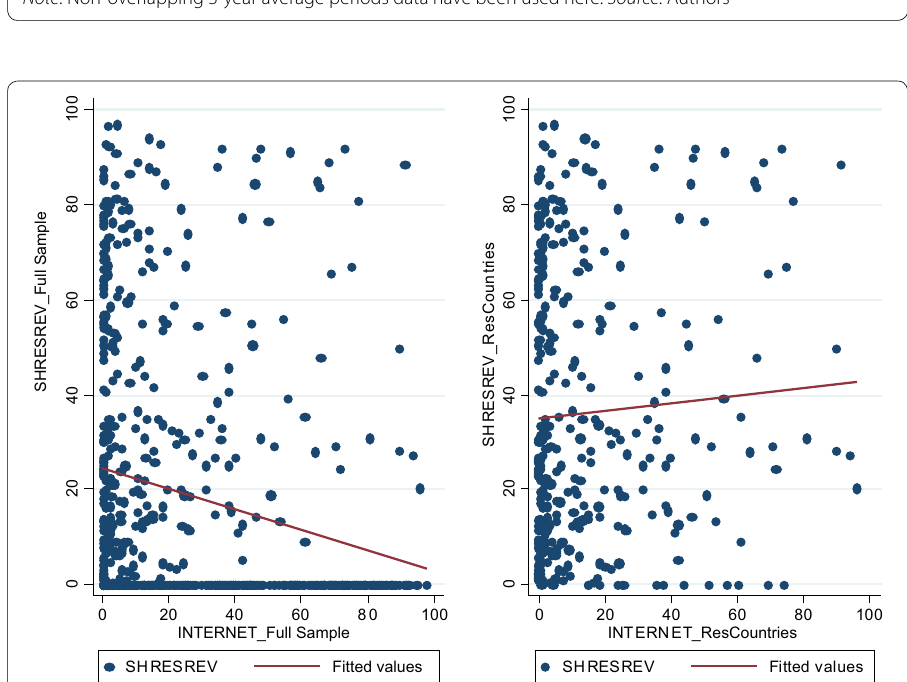
Fig. 3 Correlation pattern between “INTERNET” and “SHRESREV” over the full sample and sub‑sample of “ResCountries”. Note : Non‑overlapping 3‑year average periods data have been used here. Source :